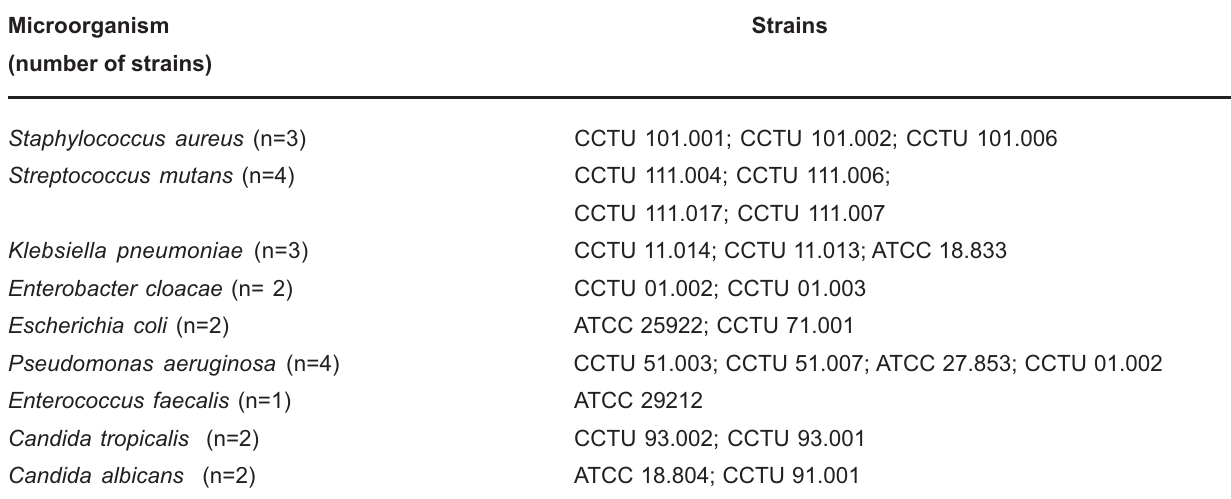
TABLE 1- Microorganisms selected for the experiment and the source of the